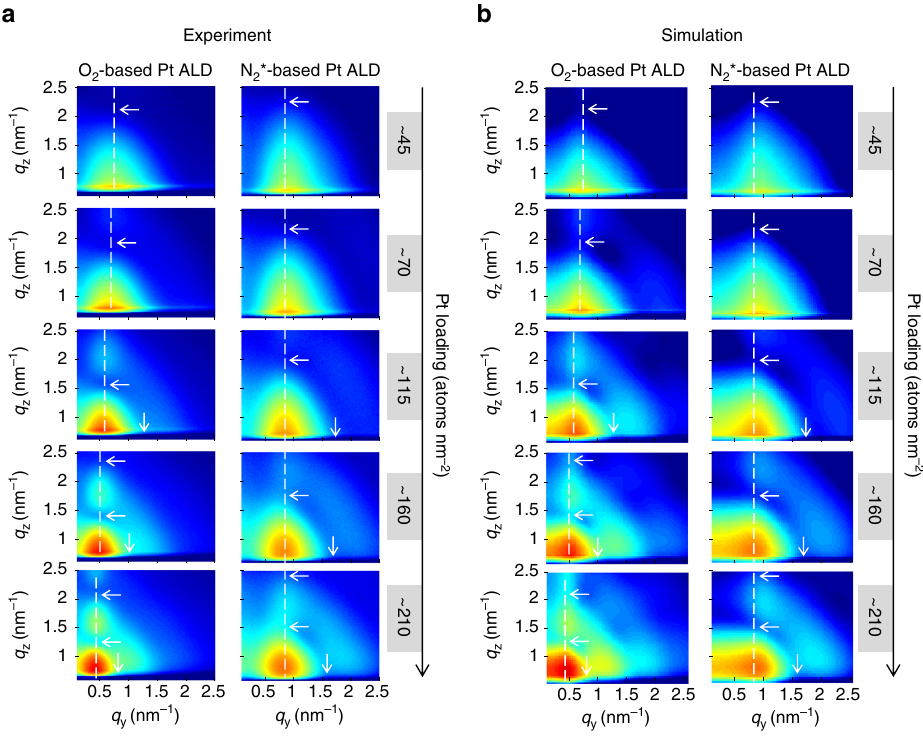
Fig. 1 In situ morphological characterization during Pt ALD processes. a Selection of experimental 2D GISAXS images measured in situ during (left) O 2 -based Pt ALD and (right) N 2 * -based Pt ALD. b Corresponding simulated patterns. All details about the calculations may be found in Supplementary Note 2 and Supplementary Figs. 7 and 8. The dashed vertical lines indicate the q y position of the main scattering lobe. The horizontal/vertical arrows indicate the minima along the q z / q y